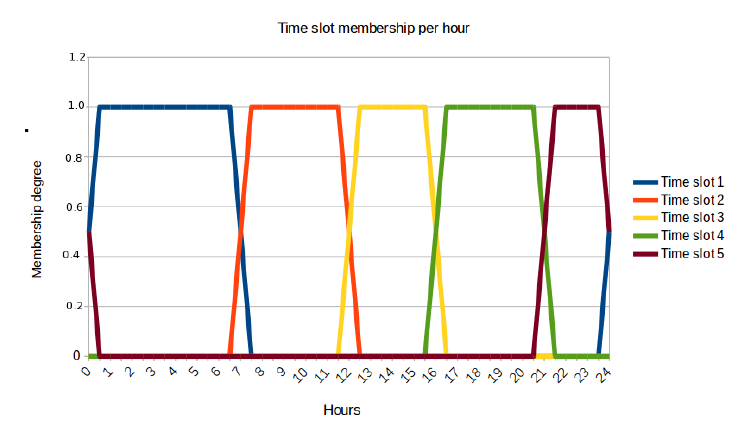
Figure 4. Fuzzy sets defining the time periods of a